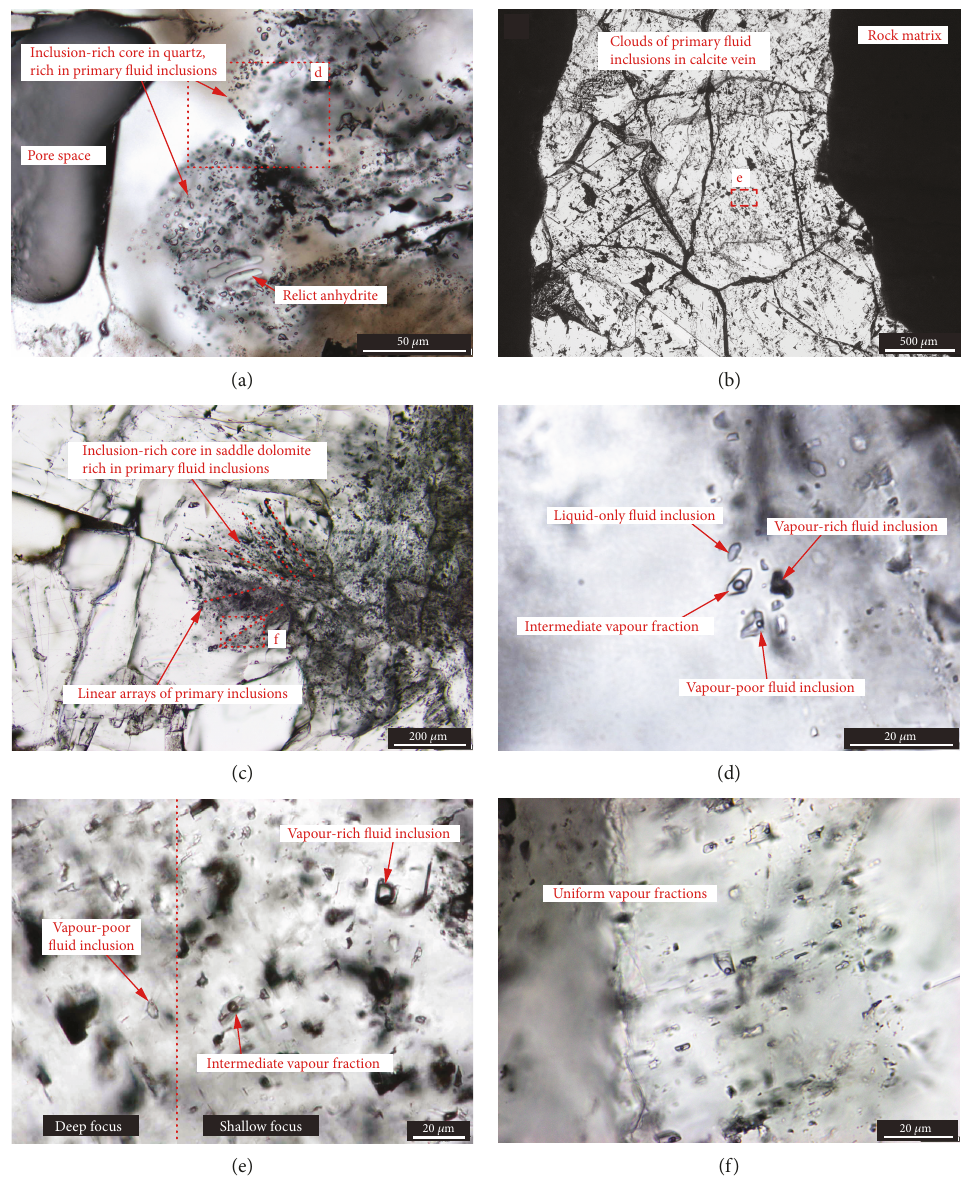
Figure 9: Assemblages of primary fl uid inclusions in secondary minerals. (a) Quartz (SLA 1127.44m). (b) Calcite (SIB 241.60m). (c) Saddle dolomite (LIN 2245.35m). Variations in phase proportions show that primary inclusions in (d) quartz and (e) calcite were heterogeneously trapped, whereas primary fl uid inclusions in (f) saddle dolomite were homogeneously trapped (see text for details; plane polarized, transmitted-light